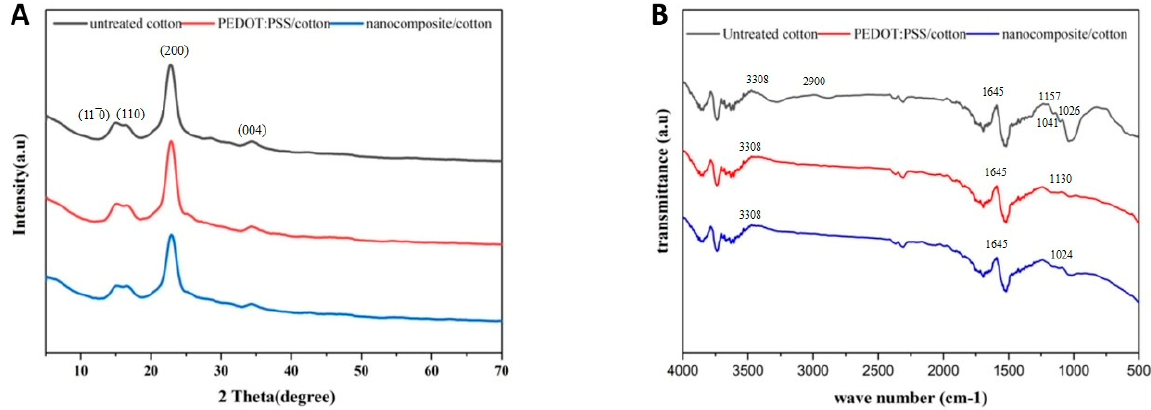
Figure 5. Comparison of XRD analysis ( A ) and FTIR spectra ( B ) of the untreated cotton fabric and cotton fabrics treated with PEDOT:PSS and